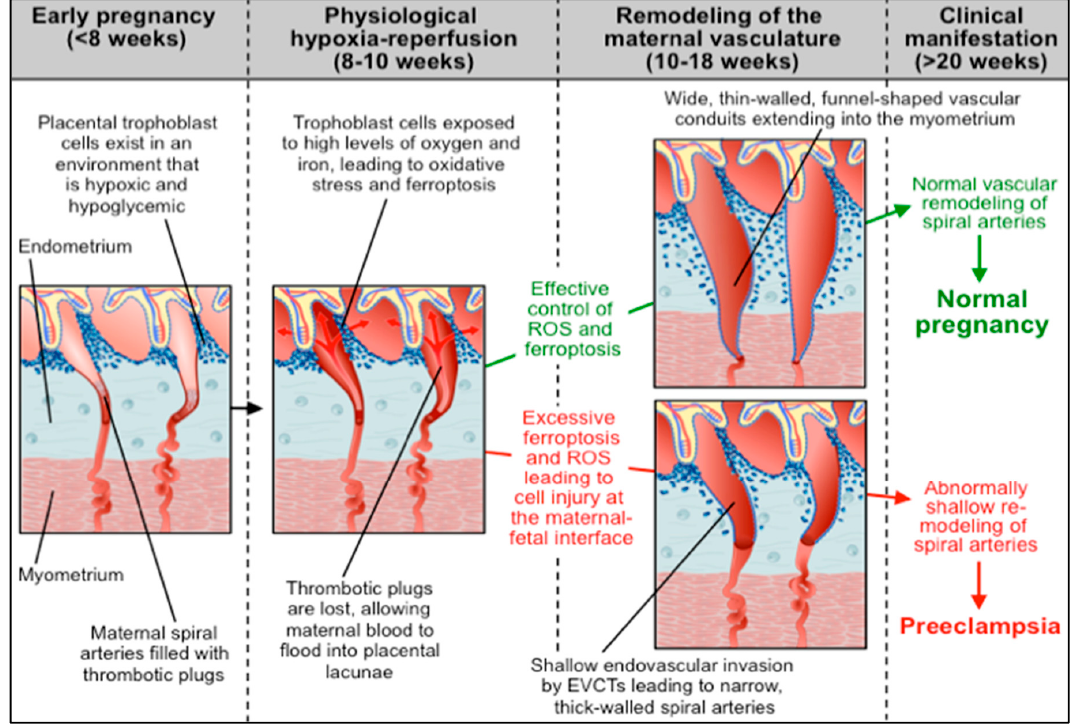
Figure 4. A novel model for preeclampsia: excessive ferroptosis and cellular injury at the maternal- fetal interface in response to the physiologic hypoxia-reperfusion events that occurs in all pregnancies at 8–10 weeks of